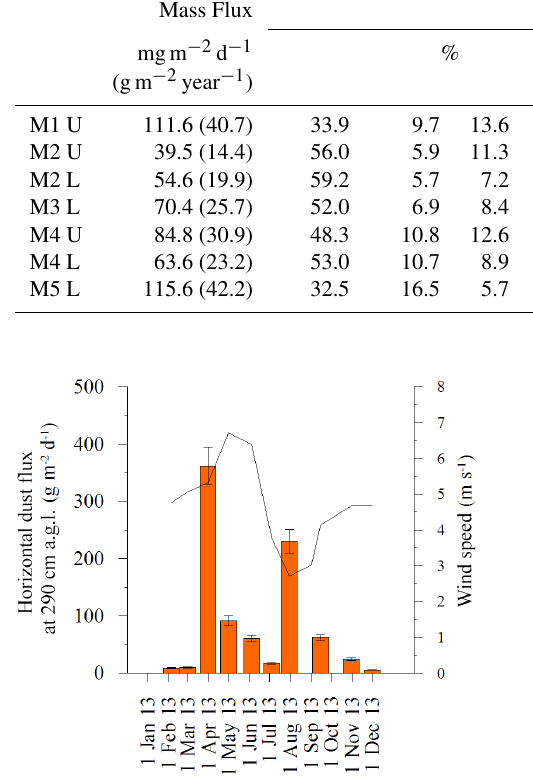
Table 3. Yearly mass fluxes of measured flux parameters. Trap Total CaCO 3 BSiO 2 OM Residual CaCO 3 BSiO 2 OM Residual Mass Flux mass mass mgm − 2 d − 1